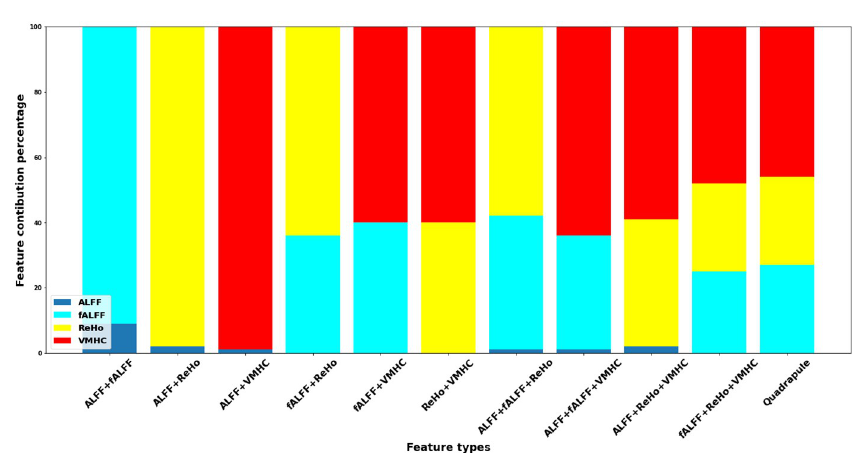
Fig 6. Contribution percentage of each of the ALFF, fALFF, ReHo, VMHC feature types in the performance of the classifiers with pairwise, triple, and quadruple feature combinations.